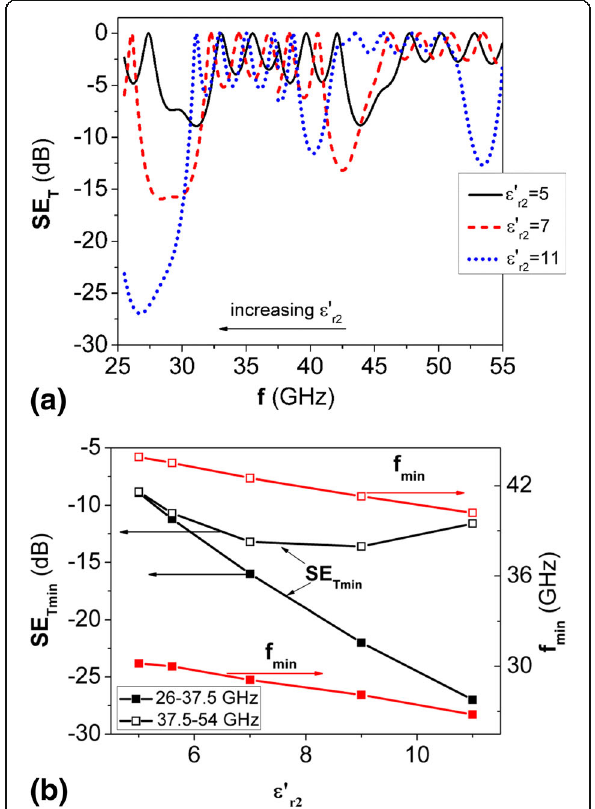
Fig. 2 Calculated EMR transmission spectra ( a ) for PS (LH) 5 at various of H-layers and dependencies of position and values of permittivity ε ′ r 2 ¼ 2 : 9; of H-layers ( b ); ε ′ r depth of PBG on permittivity value ε ′ r 2 1 d d δ ε 2 = 0.003 1 = 5 mm; 2 = 1mm; tan